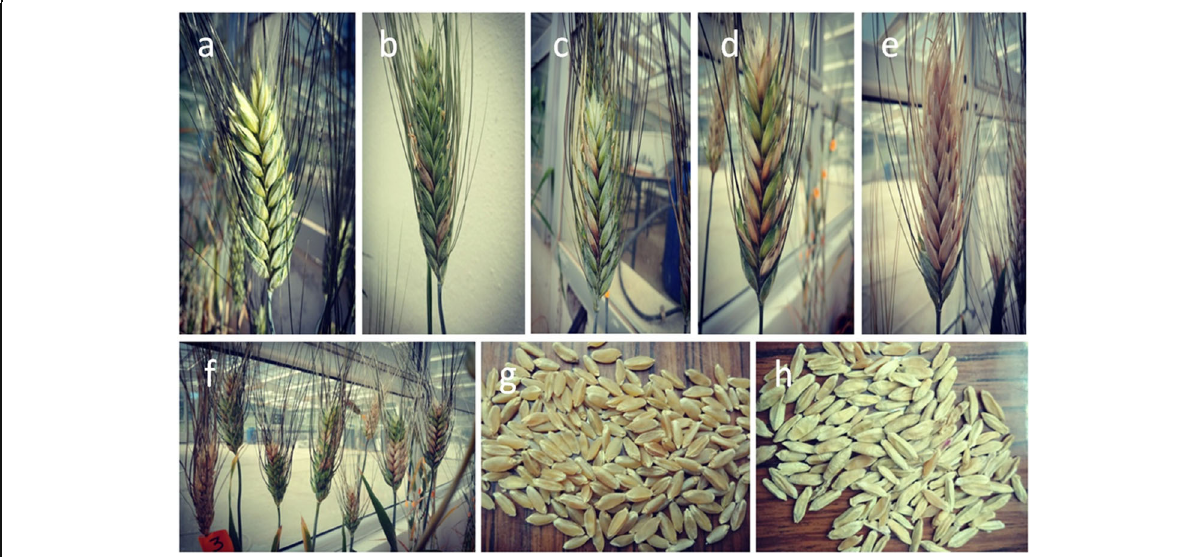
Fig. 4 Photos illustrate the different stages of FHB infection, after inoculation with FC2. a Healthy spike (control). b Start of FHB. c Spread. d 50% fusarium spike. e 100% fusarium spike. f Different stages of Fusarium disease in the same cultivar. g Healthy kernels. h Fusarium